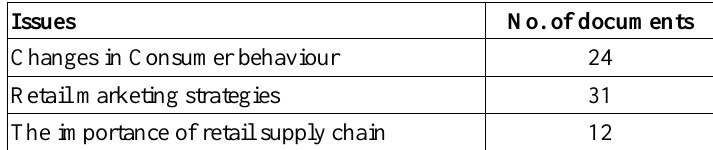
Table 1: The Issues of Academic Studies in Retail and COVID 19